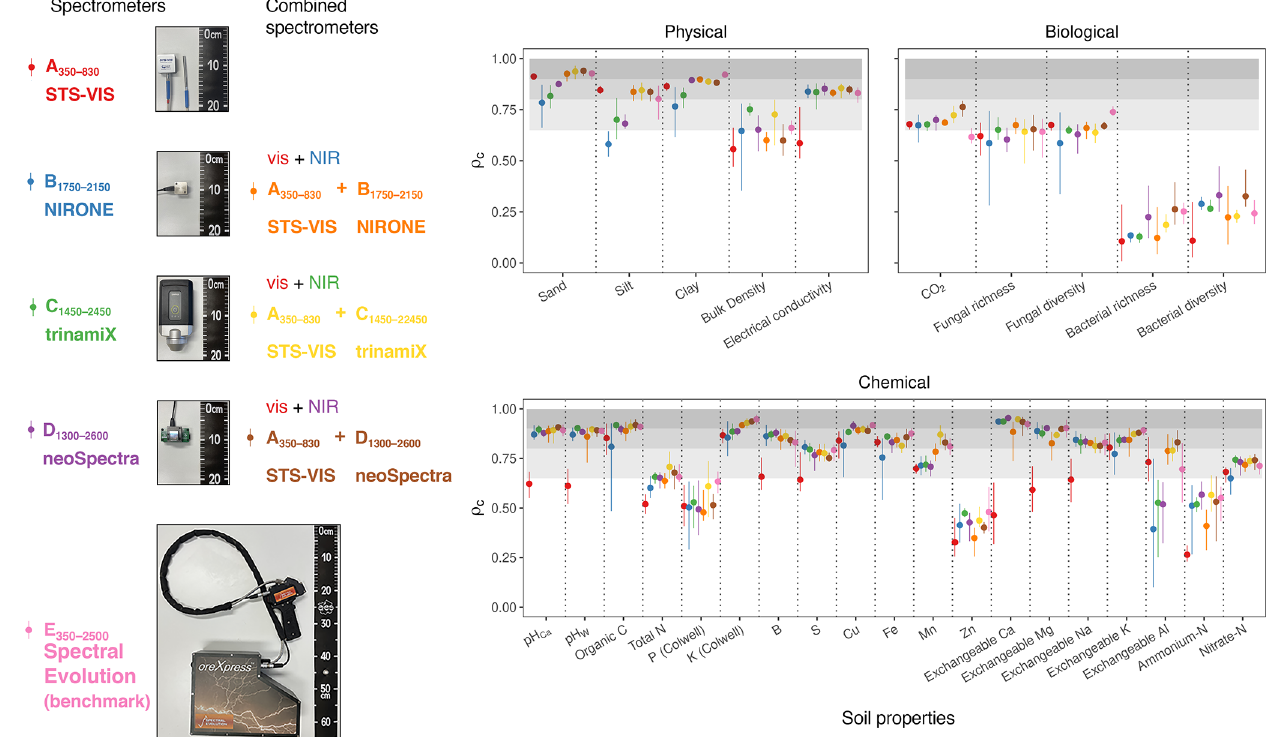
Figure 5. Photographs of the miniaturised and portable spectrometers indicating their size (cm). The spectrometer names, spectral ranges, and combinations are colour-coded and correspond with colours of the symbols on the plots. Accuracy of the spectrometers and combinations. The discs show the mean ρ c , and the range lines are the minimum and maximum values of ρ c from the best four algorithms (PLSR, Cubist, GPRL, and GPRP). The grey bands indicate the level of accuracy (moderate, substantial, and near-perfect – see caption of Fig. 4).